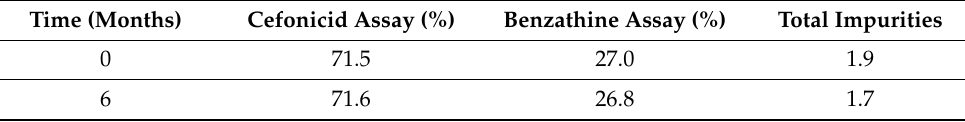
Table 4. Salt stability over 6